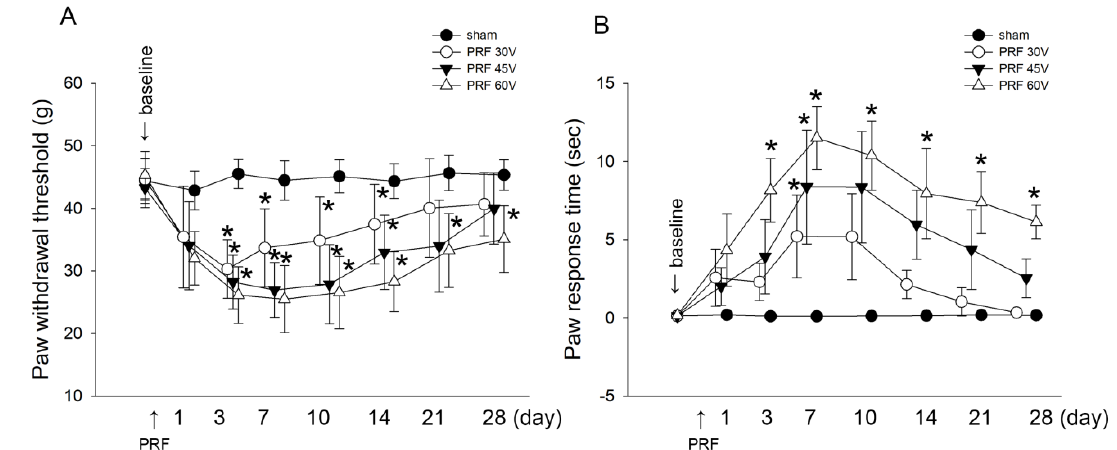
Figure 1. The paw withdrawal threshold and response time in the mechanical allodynia and cold hyperalgesia test. The behavioral and time response in rats ( n = 8) subjected to sham (●) or 30 V ( ○ ), 45 V ( ▼ ), or 60 V ( △ ) of PRF stimulation. ( A ) Mechanical allodynia was evaluated using the dynamic plantar esthesiometer. ( B ) Cold allodynia was evaluated by the acetone spray test. Sham: operated muscle. * p < 0.05 were compared with the sham group.